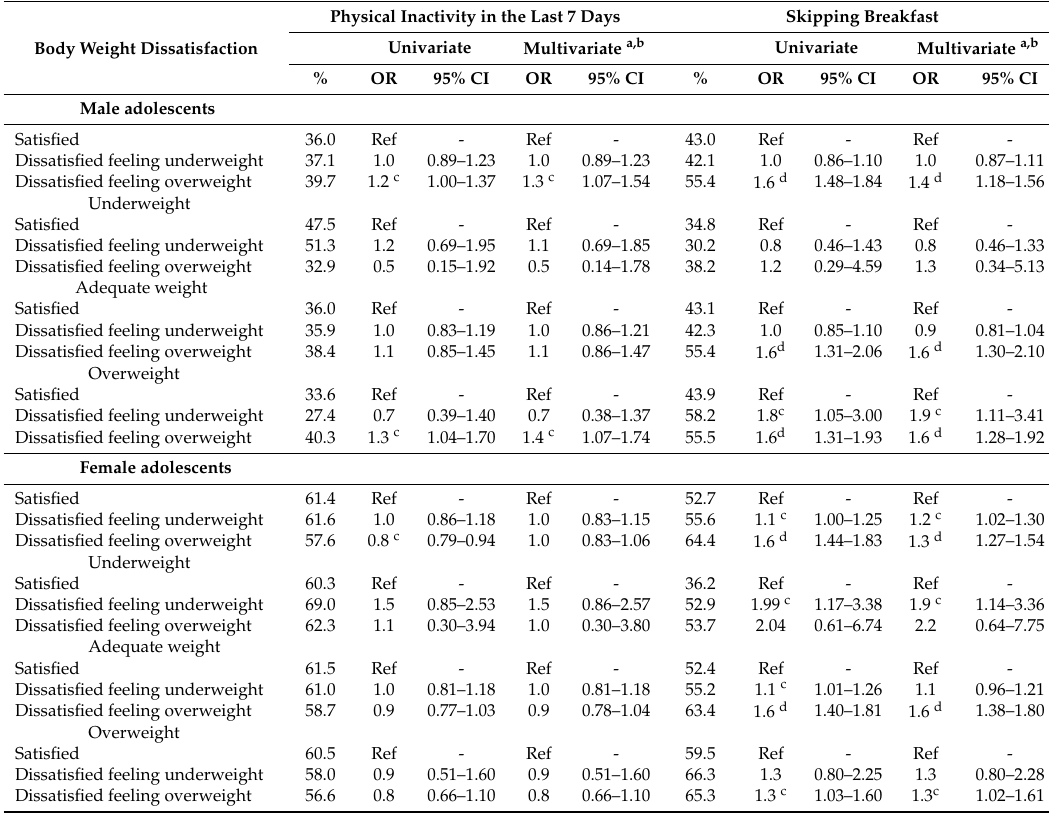
Table 4. Association between two forms of body weight dissatisfaction and cardiovascular health-risk behaviors physical inactivity in the last seven days and skipping breakfast, by